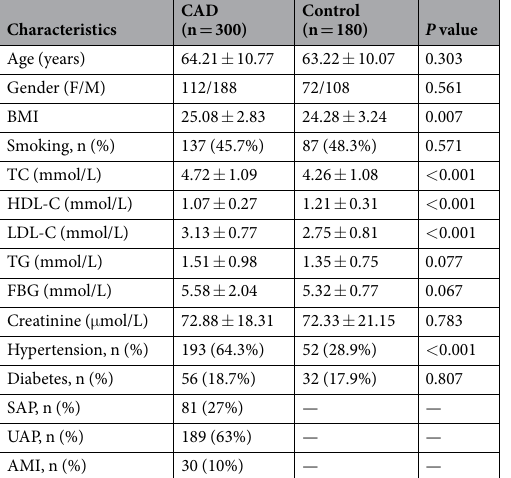
— Table 1. Characteristics of study subjects. CAD, coronary artery disease; BMI, body mass index; TC, total cholesterol; HDL-C, high-density lipoprotein cholesterol; LDL-C, low-density lipoprotein cholesterol; TG, triglyceride; FBG, fasting blood glucose; SAP, stable angina pectoris; UAP, unstable angina pectoris; AMI, acute myocardial